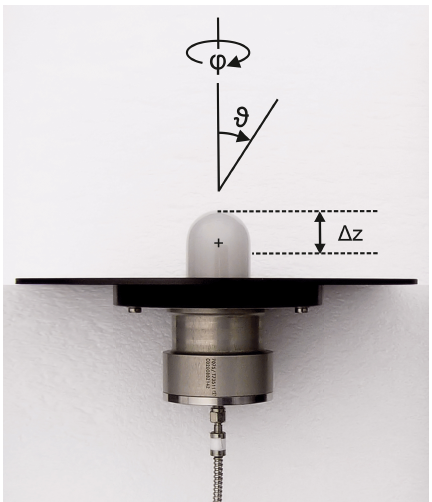
Figure 1. Photograph of a 2 π actinic radiation receiver with quartz dome (top) and optical fibre connection (bottom). Polar and azimuth angles of incidence ϑ and ϕ are indicated. Ideally the receiver col- lects radiation from a hemisphere ( ϑ ≤ 90 ◦ ). A typical distance (cid:49)z of the equivalent plane with respect to the quartz dome tip is in- dicated by the dashed lines (Sect. 3.1). The central cross indicates the normal position of the rotational axis for ϑ -dependent measure- ments (Sect. 3.1). The optical fibre connected at the bottom guides transmitted radiation to a spectroradiometer. The receiver housing was designed for HALO. In this photograph it is equipped with a lighter, 200mm round top flange substitute for ground and labora- tory measurements; see Fig. 2 for